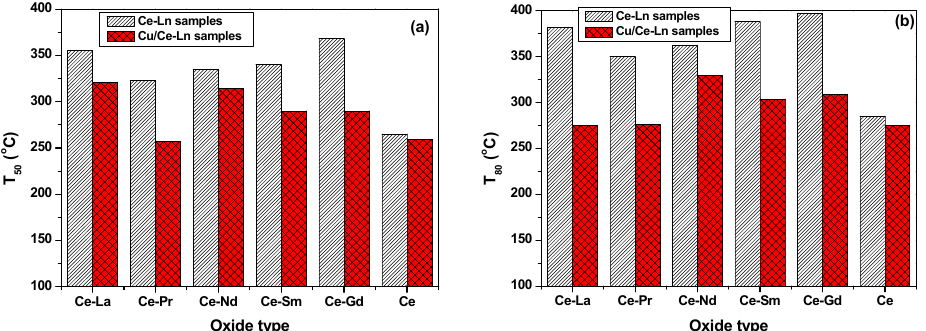
Figure 9. Comparison of EtOAc performance of CeO 2 and Ce-Ln materials, with and without Cu (Ln: Gd, La, Pr, Nd, Sm), in terms of temperature required for 50% ( a ) and 80% ( b ) conversion (T 50 and T 80 , respectively). Reaction conditions: [VOC] in = 1000 mg Carbon /m 3 , GHSV = 60,000 h − 1 . The error for catalytic experiments is ±2 °C.